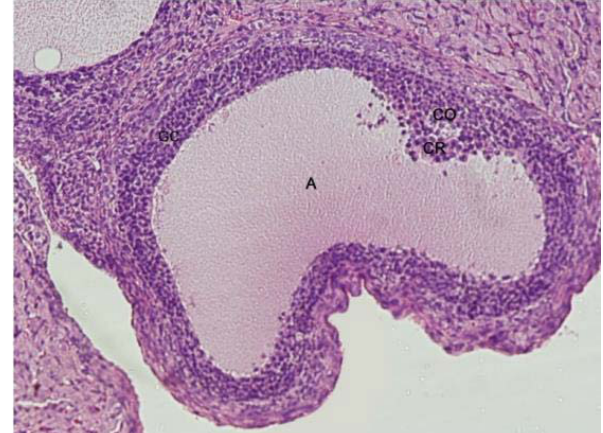
Fig-4: Photomicrograph of ovary of experimental group C having Graafian follicle showing follicular antrum (A), well arranged granulosa cell layer (GC), corona radiate (CR) and cumulous oophorus (CO), (H & E, 20x).